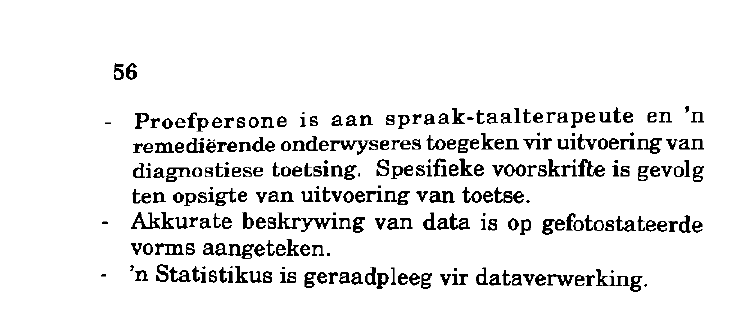
TABEL 2: Meetinstrumente wat geselekteer is om gesproke taal te evalueer Evaluasie-area